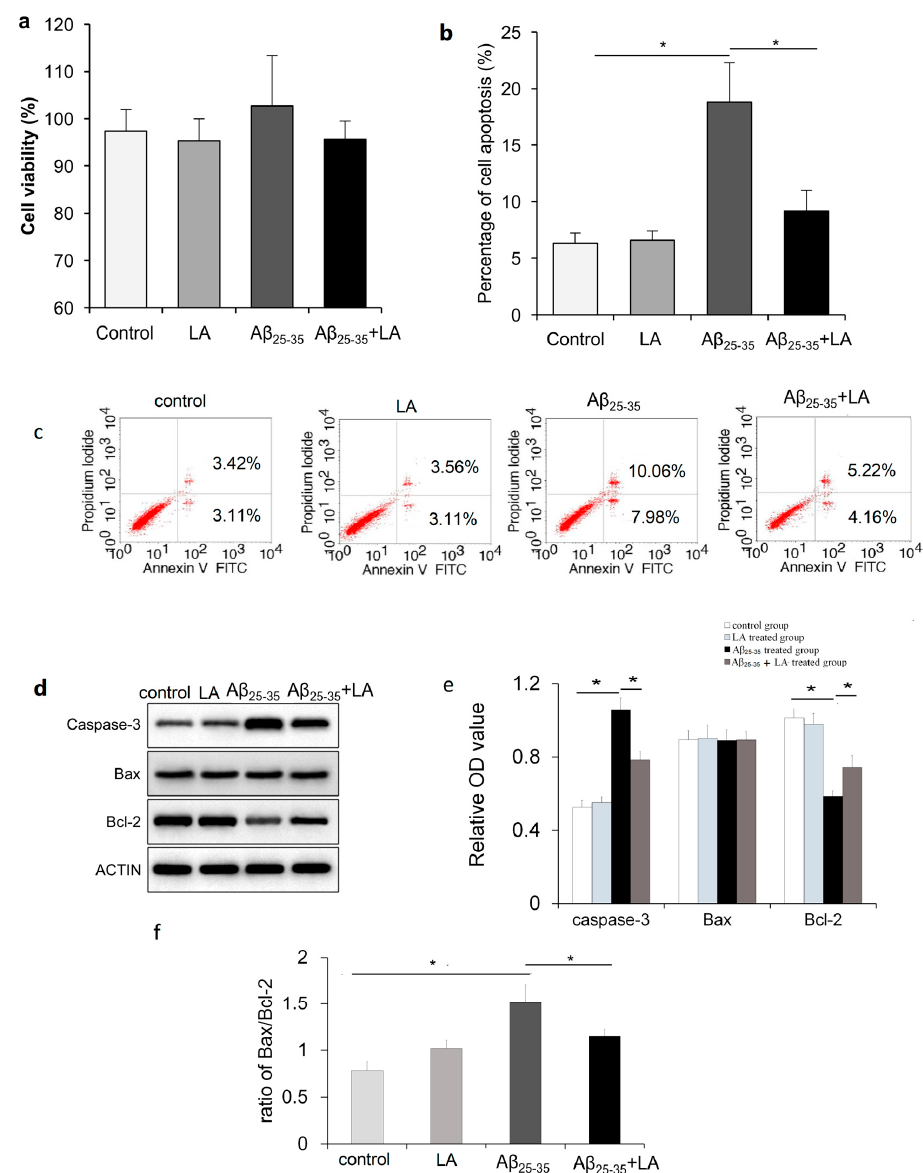
Figure 3. α -lipoic acid (LA) repressed A β 25–35 -induced BV2 cell apoptosis. ( a ) BV2 cells were treated with 25 µ mol/L A β 25–35 , 100 µ mol/L LA, or both. Cell viability was measured with the MTT assay. ( b ) Statistical analysis of the percentage of apoptosis in the different treatments. ( c ) Flow cytometric analysis of apoptosis in BV2 cells of each group. ( d ) The relative expressions of Bax, Bcl2, and caspase-3 were measured using Western blot after BV2 cells were treated with LA and/or A β 25–35 . ( e ) The statistical results of the protein expression in Western blot from d. ( f ) The ratio of Bax/Bcl-2 in each group. The data are presented as the mean ± SD of three independently performed experiments. * p < 0.05.